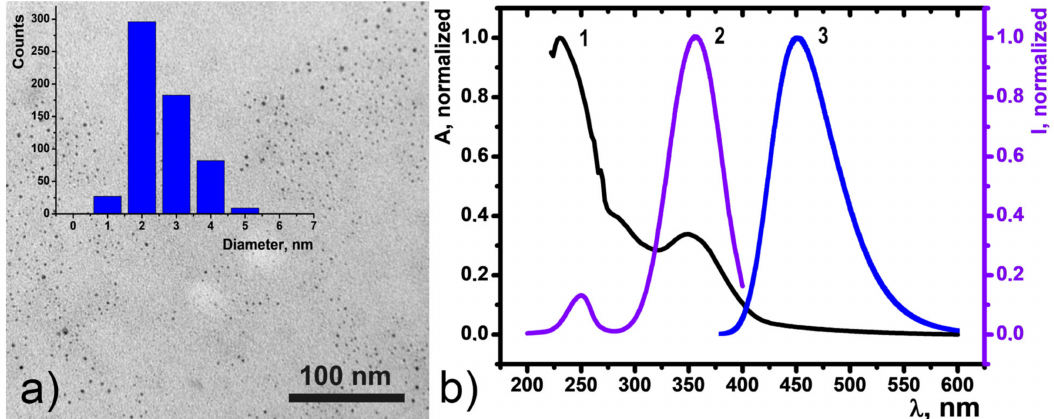
Figure 2. ( a ) TEM image of dried CDs and corresponding size distribution diagram (inset). ( b ) UV-Vis absorption spectrum (1), room temperature excitation (2, λ em = 450 nm) and fluorescence (3, λ ex = 360 nm) spectra of a 10 mg mL − 1 CD aqueous dispersion.